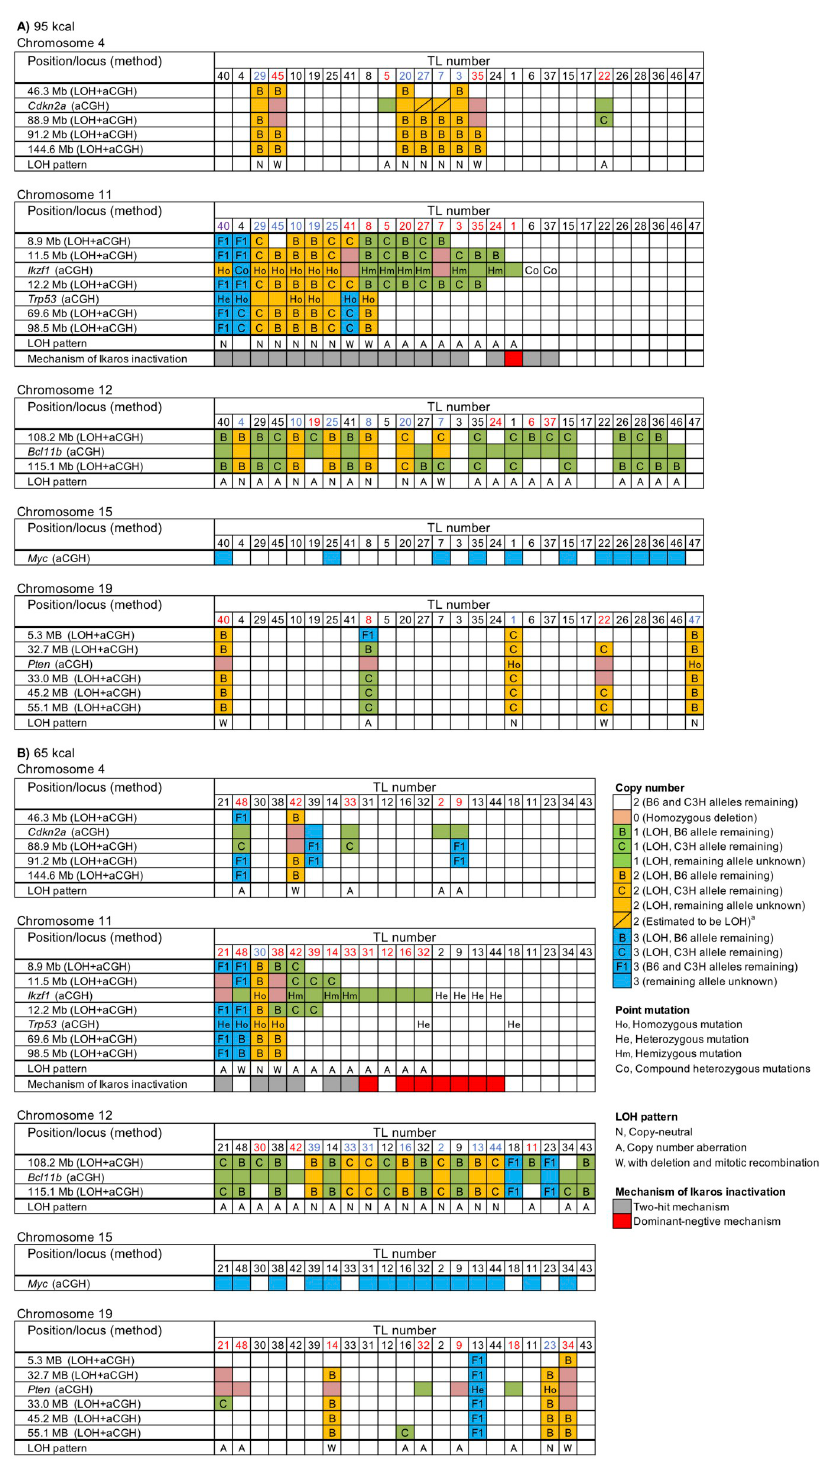
Fig 2. Detailed results of DNA copy number, LOH, and point mutations in radiation-induced TLs. Data are presented for chromosomes 4, 11, 12, 15, and 19 from 48 TLs (95 kcal, n = 27, ( A ); 65 kcal n = 21, ( B )). Columns represent individual tumors, which are common in five panels for the same calorie group, ordered manually so that similar alterations are horizontally grouped. Rows represent integrated LOH and/or DNA copy-number (aCGH) data. Chromosomal locations noted in the leftmost columns are from the NCBI37/mm9 positioning. TL numbers in